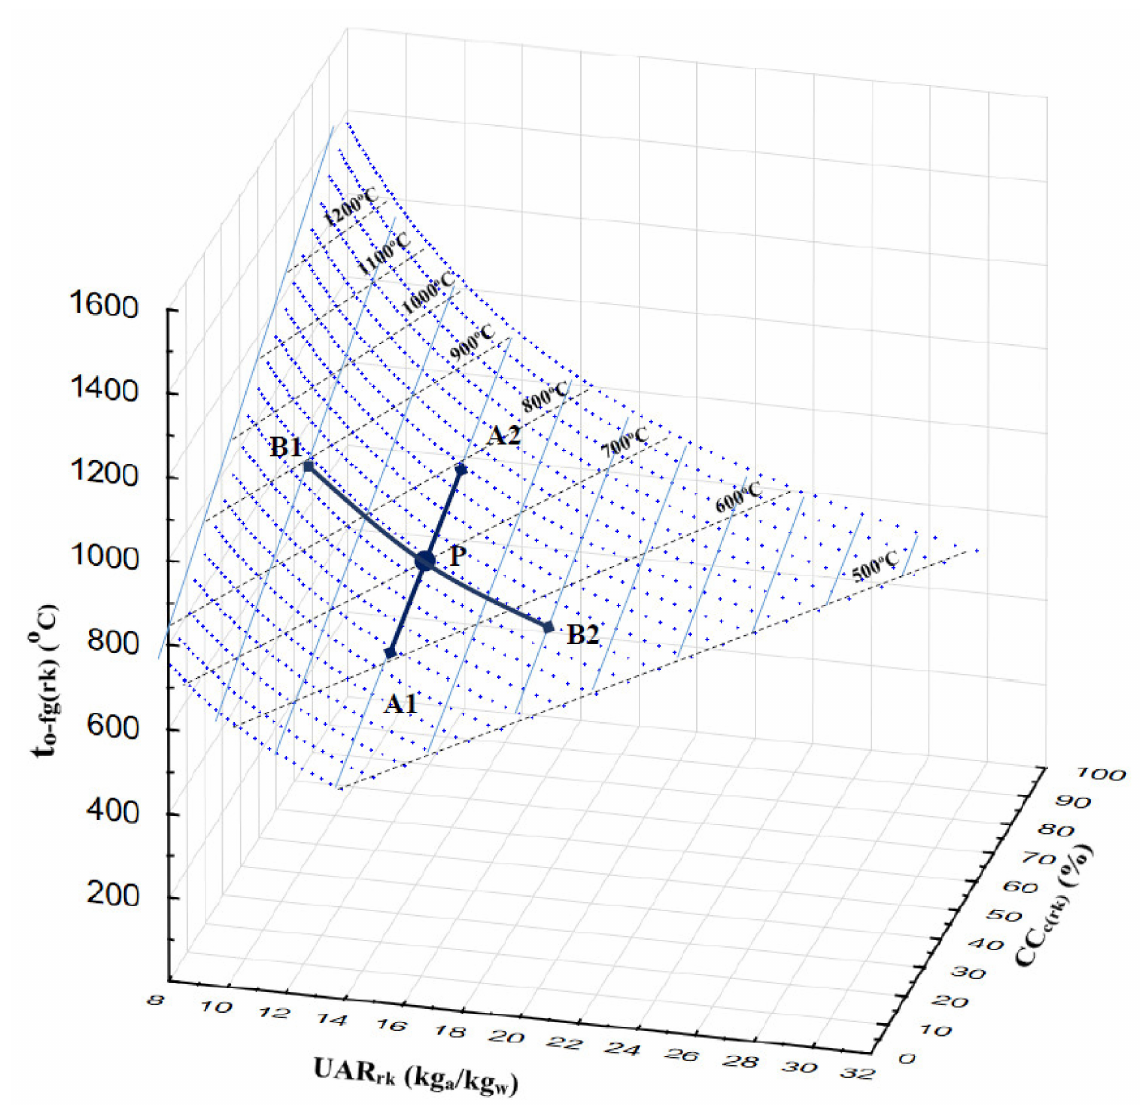
Figure 2. A temperature distribution chart for temperatures at RK flue gas outlet (rotary combustion